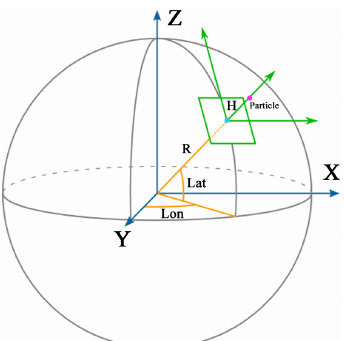
Figure 9. Cartesian coordinate system and geographic coordinate system